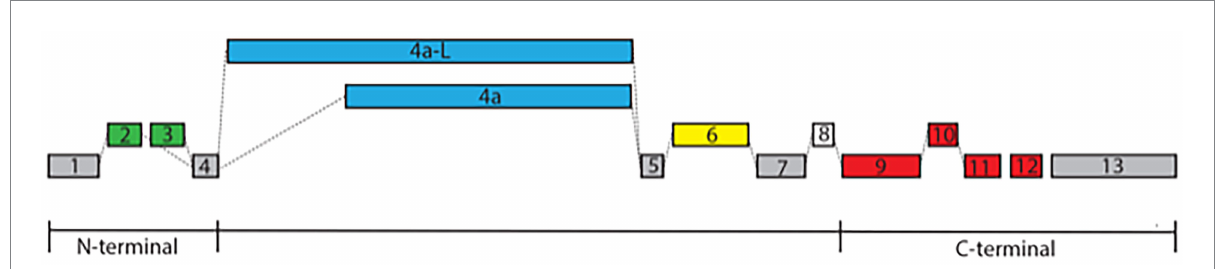
FIGURE 1 Exon structure of MAPT. The exon structure of MAPT derived from the Ensemble and NCBI databases includes alternative splicing at the N-terminal with either exons 2 and 3 or exon 2 alone labeled in green (exon 3 is always associated with exon 2), exon 4a or its longer form of 4a-L defining Big tau labeled in blue, exon 6 with 3 splice sites (6c, 6p, and 6d) labeled in yellow, exon 8 labeled in white, and exon 10, which is one of the MTBD defining the 3R/4R isoforms labeled in red. The constitutive exons 1, 4, 5, 7, and 13 are labeled in gray. Note that these alternative splicing can generate multiple isoforms with distinct temporal and spatial